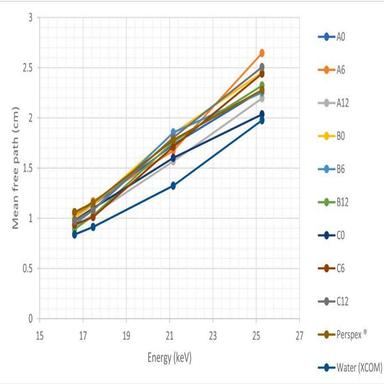
The mean free path variation for Rhizophora spp. samples, Perspex ® and XCOM of water against low energies.